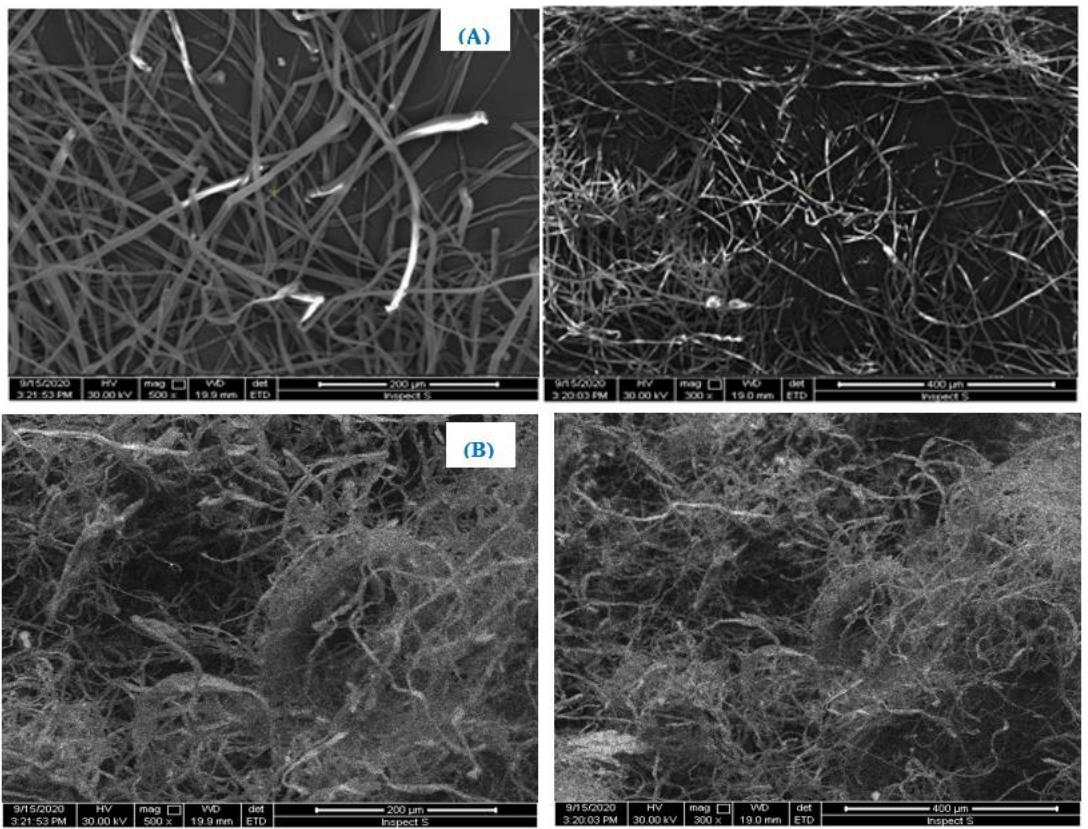
Figure 2. SEM images of: ( A ) untreated Populus tremula fibers and ( B ) extracted cellulose observed at different magnifica- tions.